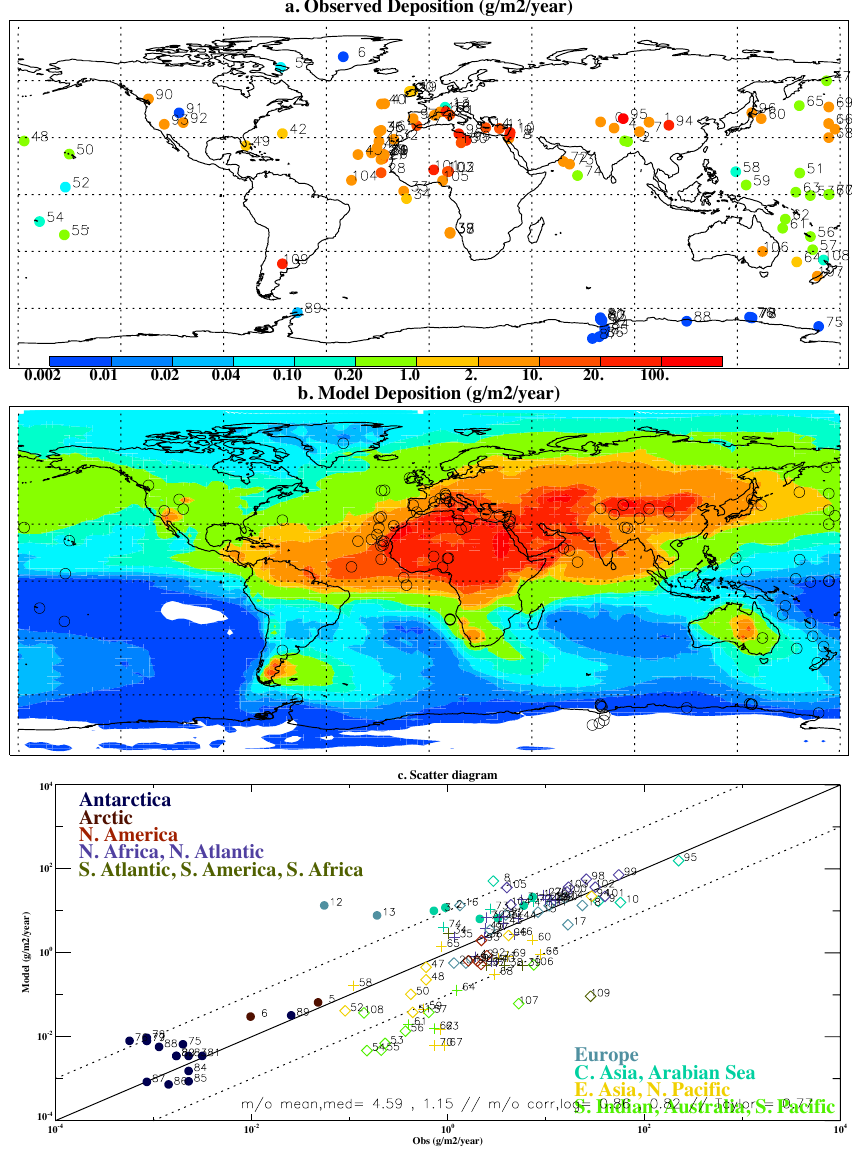
Figure 12. (a) Observational and (b) modeled dust deposition (gm − 3 yr − 1 ). The scale is the same for both panels. (c) A scatterplot shows the comparison between the model and observations. The correlation coefficient between observations and model results is